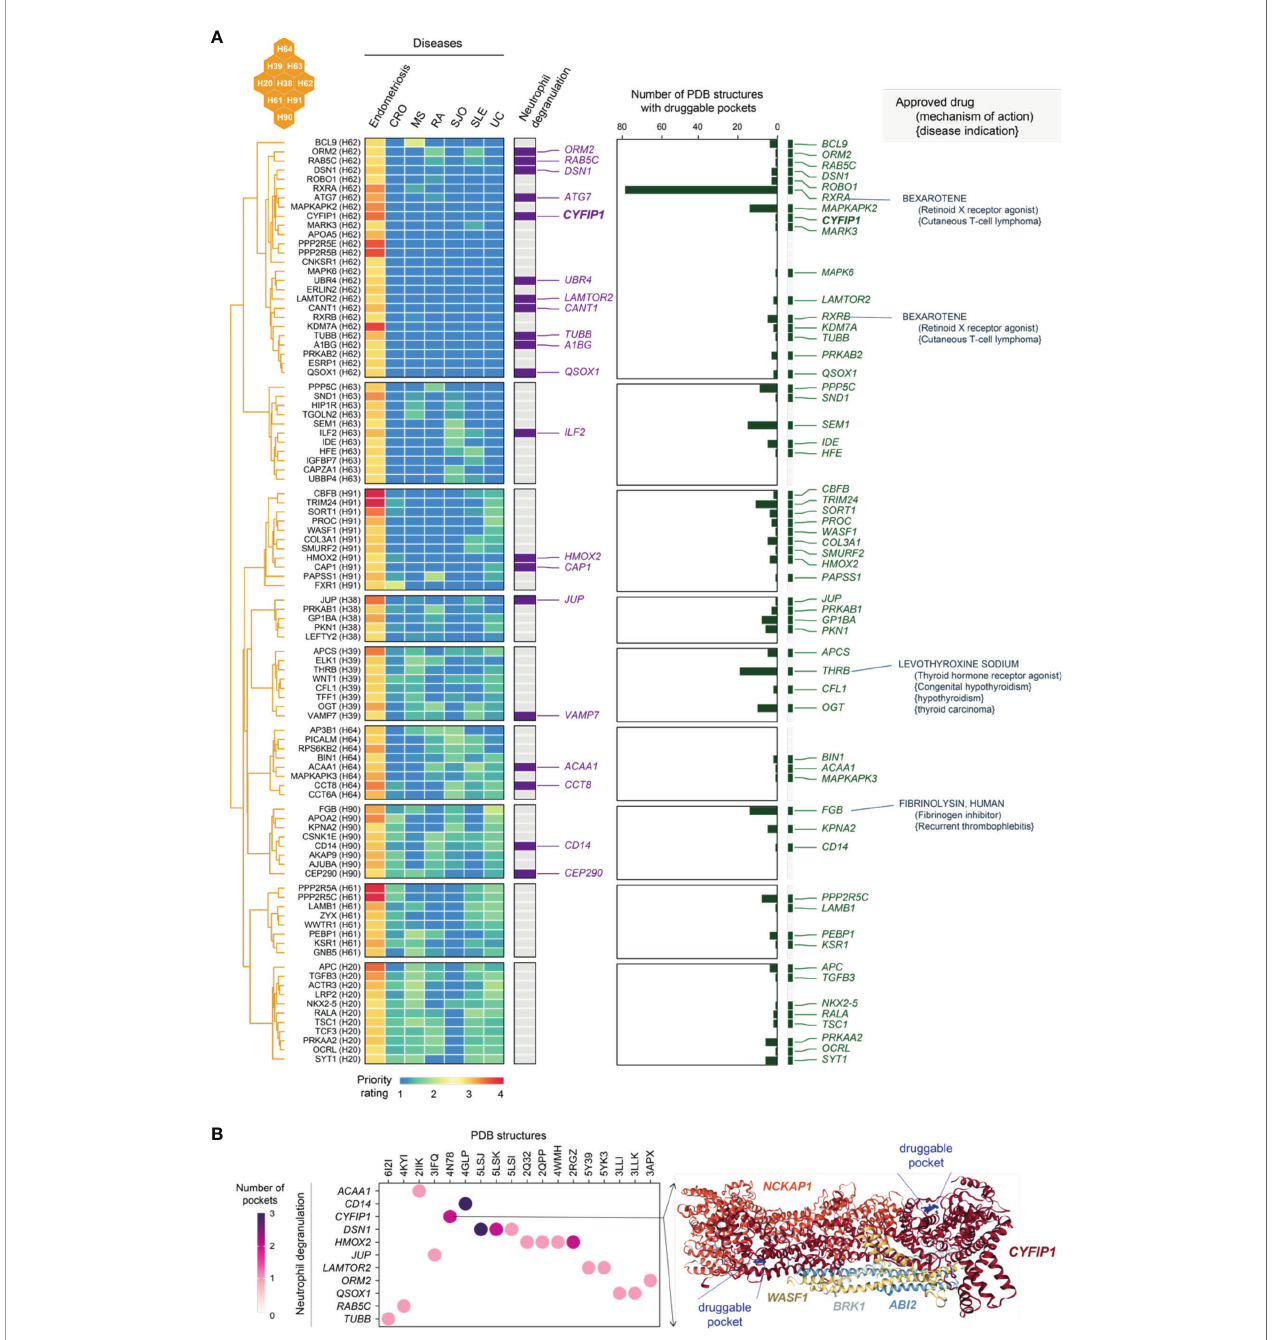
FIGURE 10 | Tractable evidence for targeting neutrophil degranulation based on genes prioritized speci fi c to endometriosis in the cluster C5. (A) Heatmap illustrates target genes in C5 prioritized across 7 diseases, together with the information on functional relevance to neutrophil degranulation, the tractability (the number of druggable pockets), and therapeutic approval (approved drug targets, repurposed drugs, mechanisms of action, and disease indications). (B) Druggable pockets for genes prioritised speci fi c to endometriosis in C5. Dot plot shows 11 tractable genes involved in neutrophil degranulation (y-axis) and their PDB known protein structures (x-axis). Color-coded is the number of druggable pockets predicted based on the PDB structure. On the right is an exemplar illustrating an experimentally resolved WAVE regulatory complex coded as ‘ 4N78 ’ in PDB. This structure consists of 5 genes including CYFIP1 , where two druggable pockets are predicted (as indicated in blue balls and labelled as